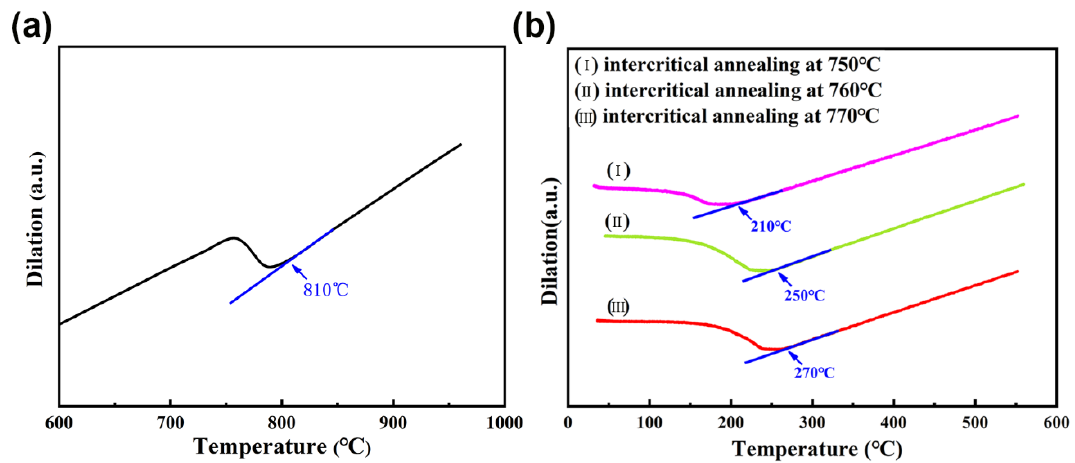
Figure 2. ( a ) Dilation–temperature curves to measure the Ac3 temperature, ( b ) dilation–temperature curves to measure the Ms temperature after intercritical annealing.